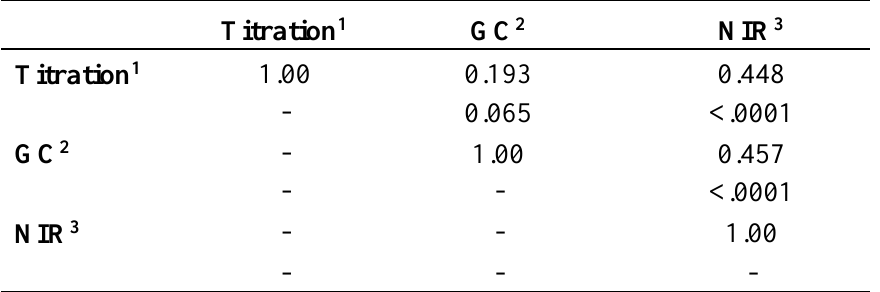
Table 10 . Pearson Correlation Coefficients and P-values for three measures of iodine value in belly fat of pigs fed a control